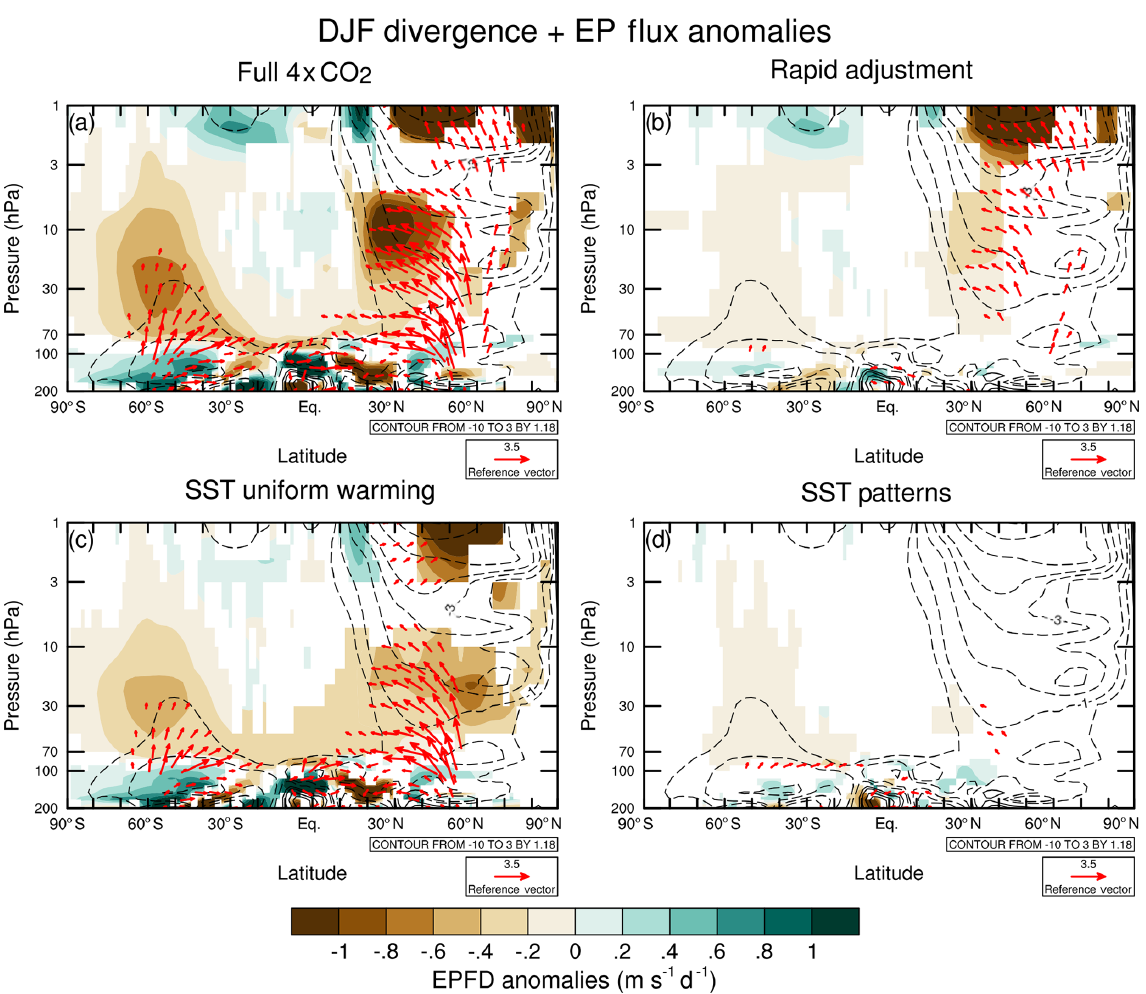
Figure 7. DJF average EPF vector anomalies (red arrows) (m 2 s − 2 ) and EPF divergence anomalies (ms − 1 d − 1 ) (shading) between 200 and 1hPa with respect to the piControl simulation for the (a) 4 × CO 2 (run B), (b) rapid adjustment (run C), (c) uniform SST warming (run D), and (d) SST pattern (run E) experiments. The EPF divergence here is multiplied by the cosine of latitude to represent the torque exerted on the zonal flow. Contours show the piControl climatology with contours plotted at − 10, − 8, − 6, − 4, − 3, − 2, − 1, − 0 . 5, 0.5, 1, 2, and 3ms − 1 d − 1 . The EPF vector and divergence anomalies are only plotted where they are significant at the 95% confidence level using a two-tailed Student’s t test. The EPF vectors have been scaled following Edmon et al. (1980) and were scaled by a magnification factor of 5 in the stratosphere in order to enhance their